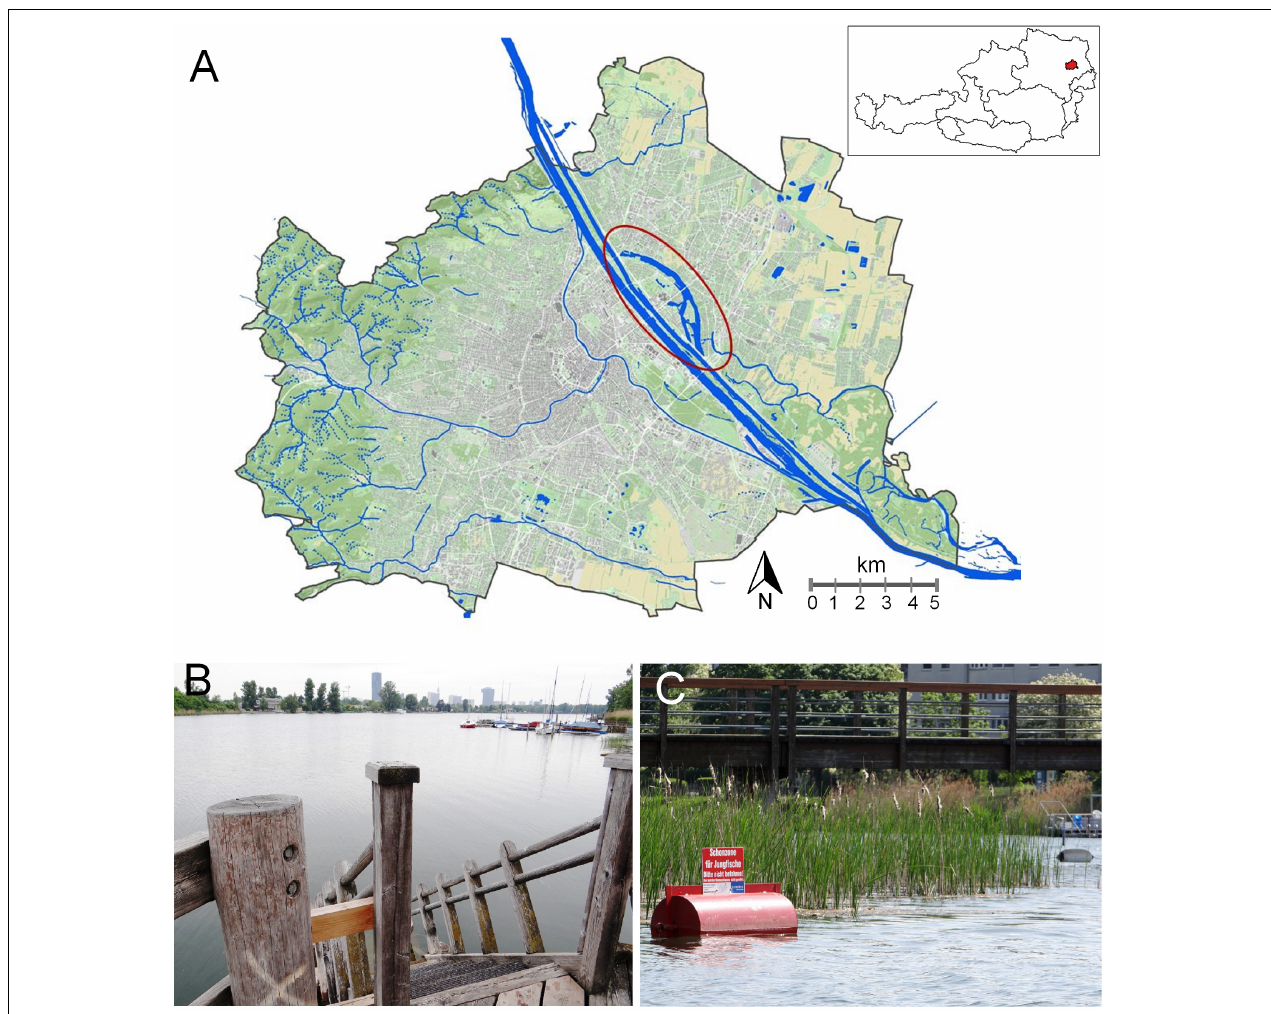
FIGURE 1 | Alte Donau- tightly coupled urban settlement and nature space. (A) Water city map Vienna. The ellipse indicates the oxbow-lake Alte Donau, in the close neighborhood of Neue Donau and the Danube River. Inset: Country map of Austria with Vienna (marked red). (Data source: City of Vienna – https://data.wien.gv.at; Inset: created using data from https://www.data.gv.at/katalog/dataset/bev_verwaltungsgrenzenstichtagsdaten150000). (B) Elongated impoundment shape due to the former main stretch of the Danube River. Reed belts ( Phragmites australis in association with other reed belt plants) were re-planted on both banks. Use of cultural ecosystem services are indicated by boats and public wooden bathing platforms providing access to the open water for free. (C) Littoral area protected for young fish, close to a lake bank with urban settlements. Buoy reminds visitors by swimming or boat to stay away respecting nature. Sign with words “Schonzone für Jungfische. Bitte nicht befahren. Hier werden Wasserpflanzen nicht gemäht.” (B–C) taken in 2015, from